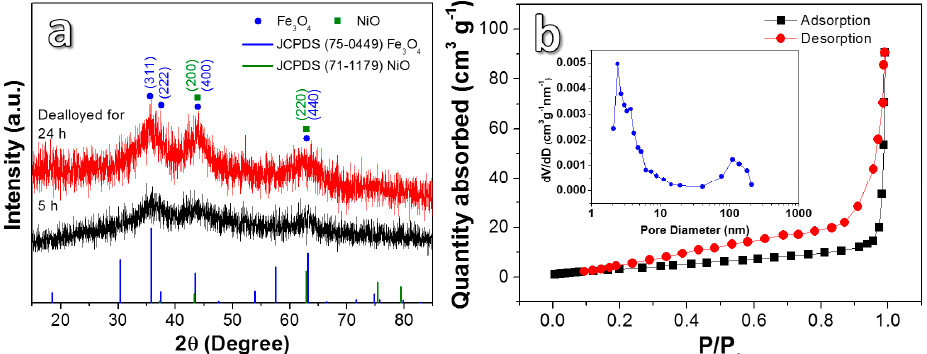
Figure 3. ( a ) XRD patterns of Ni 5 Fe 5 Al 90 ribbons dealloyed in 2 M NaOH solution for di ff erent times; ( b ) N 2 adsorption / desorption isotherm characteristics and pore size distribution of the sample dealloyed for 24